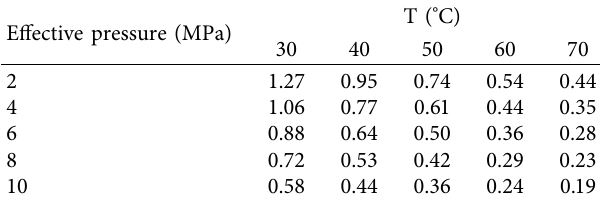
Table 4: The percolation rate of coal under different effective pressure at the pressure of 1.5 MPa.